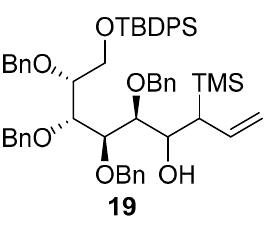
Figure 3. The structure of silanol 19 .